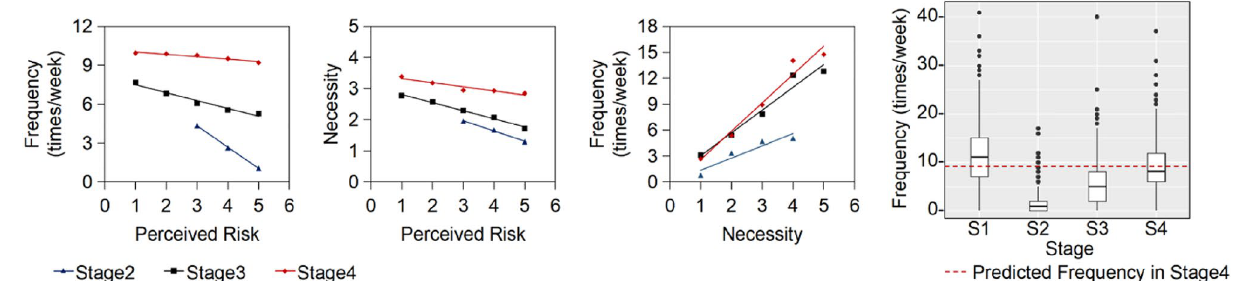
Figure 5. Linear relationship between perceived risk, necessity, and